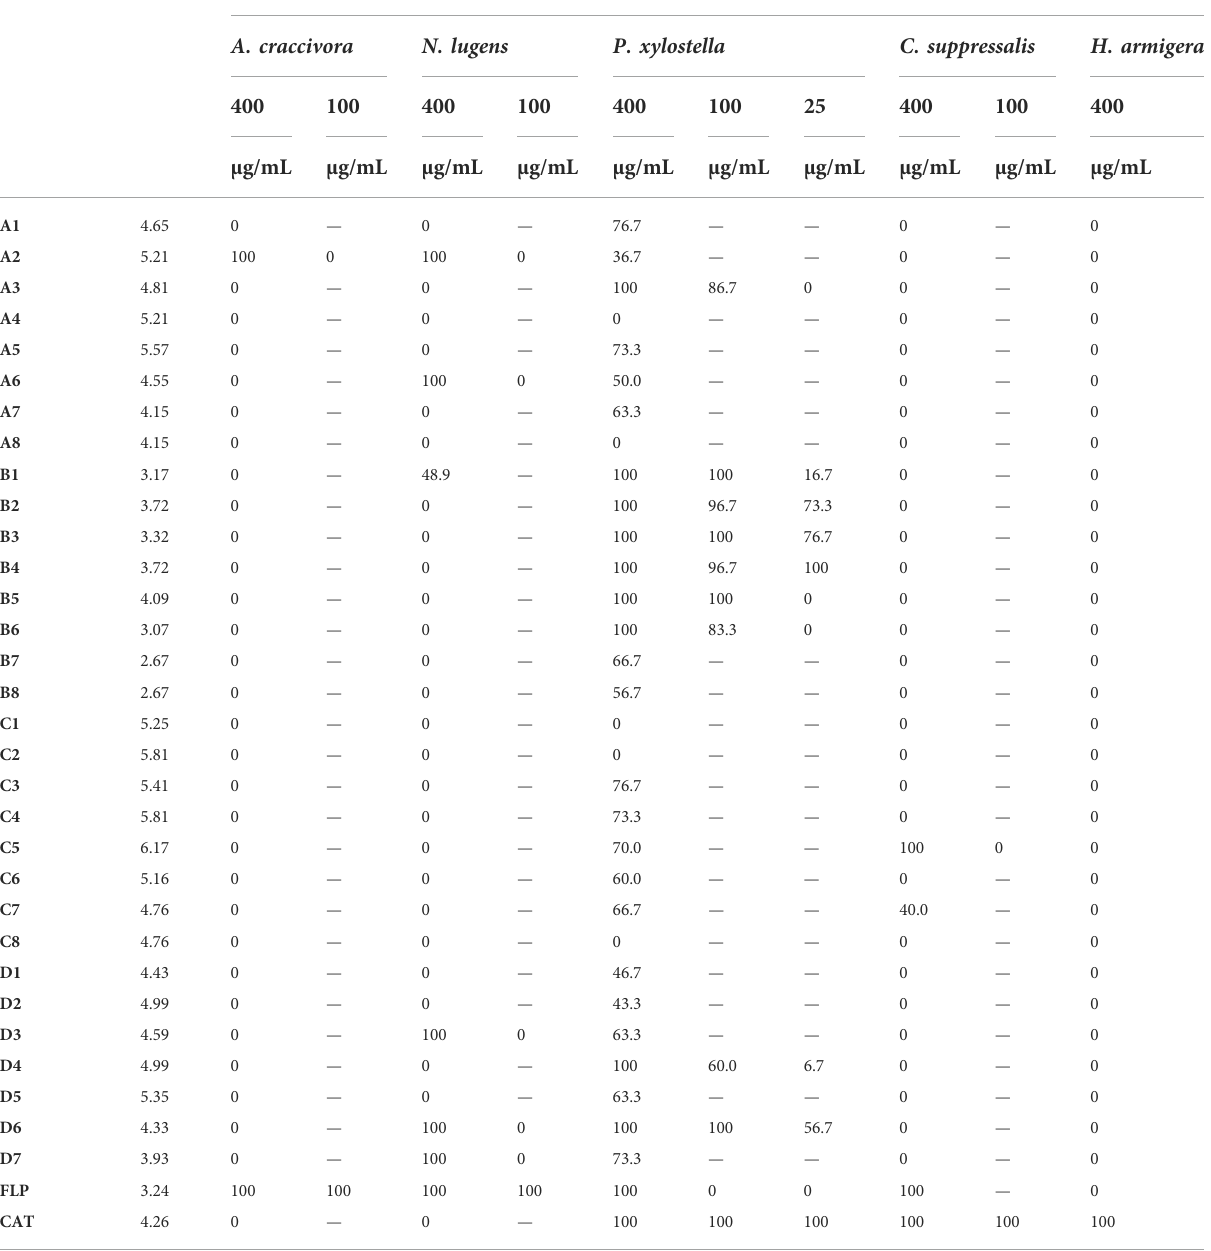
TABLE 2 Insecticidal activities of the target compounds at 400 μ g/ml.